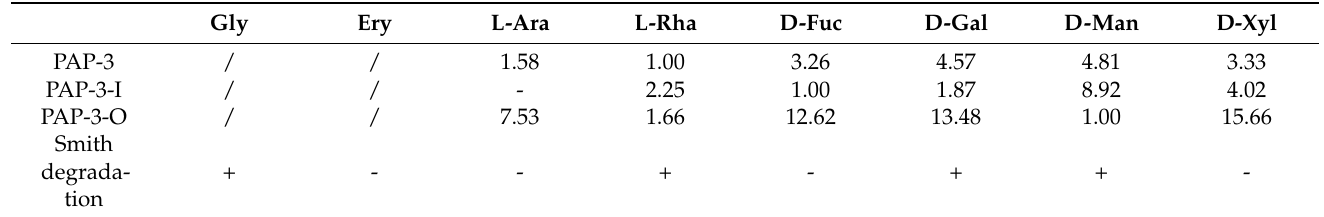
Table 1. Results of monosaccharide composition, partial acid hydrolysis, Smith degradation of PAP-3 from P. aquilinum .